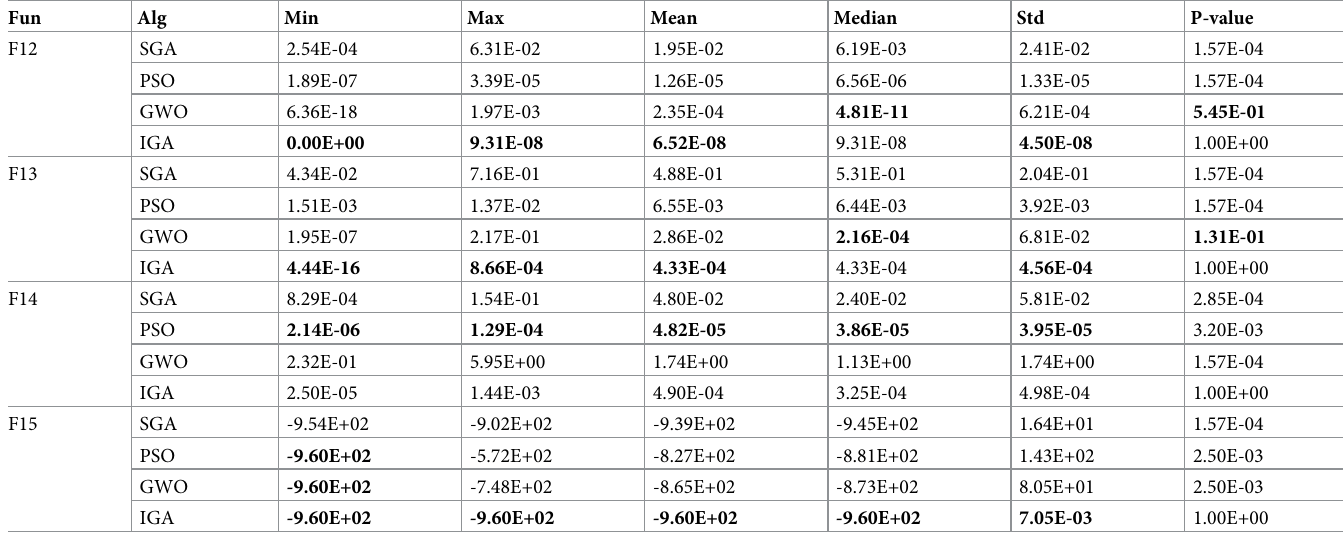
Table 8. Results of test functions (F12–15) with fixed dimensions.